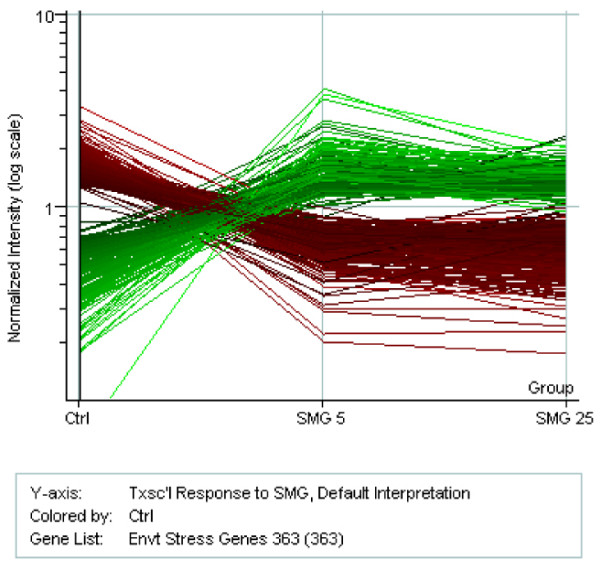
A comparison of the low-shear modeled microgravity response (SMG) with a previously identified list of 868 S. cerevisiae Environmental Stress Response (ESR) genes with a fold change >2 identified by Gasch et al. (2002). 363 genes from our dataset change > 2-fold under all conditions.